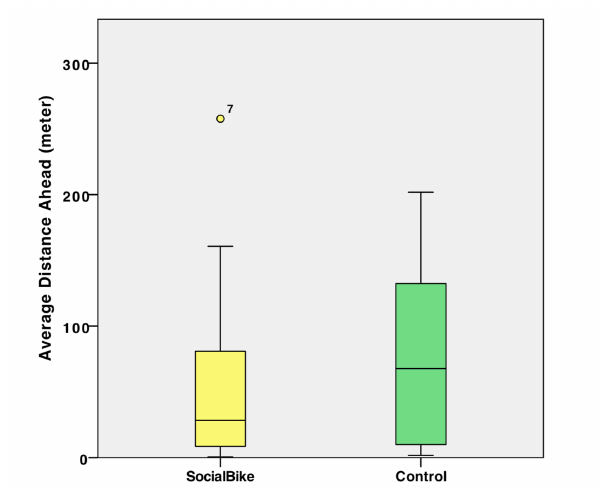
Figure. 22. The result of Average Distance Ahead (meter)